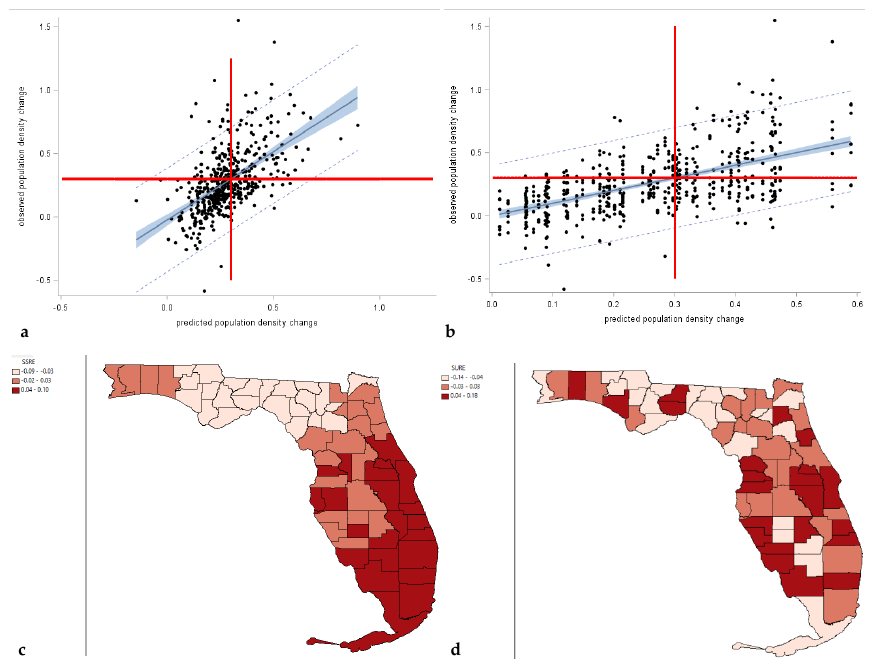
Figure 6. Selected publicly available space-time dataset visualizations of change in Florida decennial census log-population density, 1930-2010. Top left ( a ): a scatterplot of the space-time autoregressive predicted and observed values, with 95% confidence (solid blue) and prediction (dotted blue lines) intervals. Top right ( b ): a scatterplot of the RE-based predicted and observed values, with 95% confidence (solid blue) and prediction (dotted blue lines) intervals. Bottom left ( c ): a tertile map of the SSRE component. Bottom right ( d ): a tertile map of the SURE component.